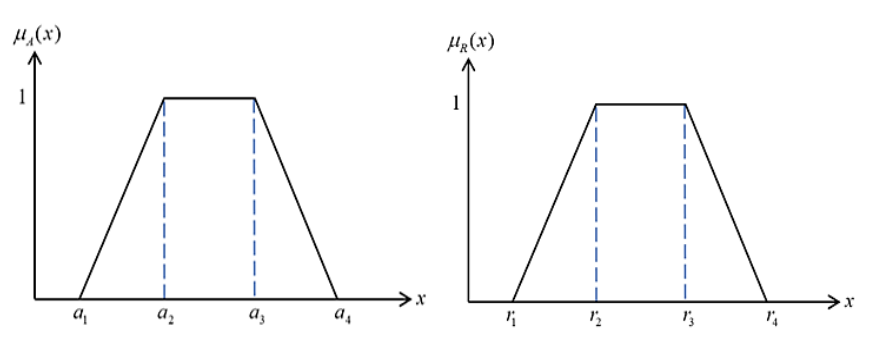
Fig. 2. Representation of a Z-number for trapezoidal fuzzy